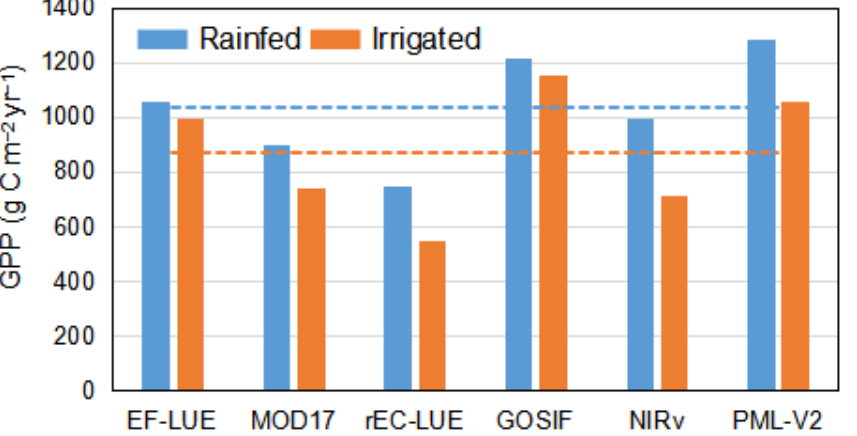
Figure 9. Comparison of annual mean GPP simulated by the EF-LUE model with other five different GPP products in rainfed and irrigated croplands from 2002 to 2018. The blue and orange dashed lines are the average GPP values of all 6 GPP products over rainfed cropland and irrigated croplands, respectively.